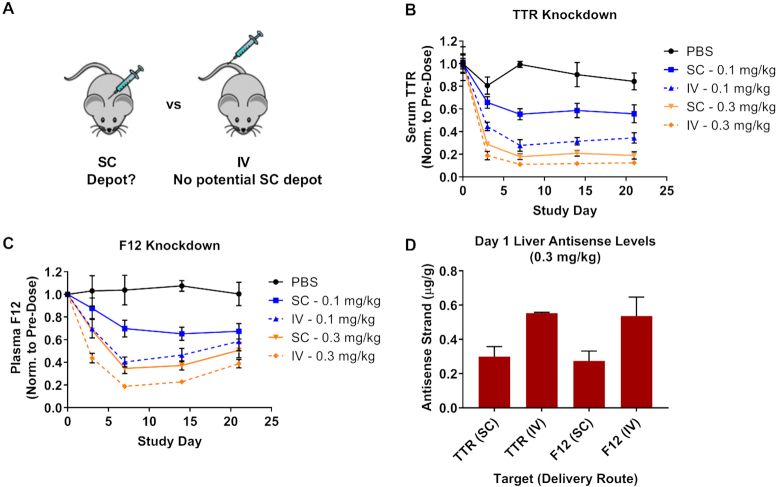
The SC site of injection is not a depot for GalNAc–siRNA conjugates. (A) Schematic illustrating the location of SC (back) and IV (tail) injection sites for the GalNAc–siRNA conjugates used in this comparison (note: IV-injected GalNAc–siRNA was not LNP-formulated). (B, C) Cohorts of mice (n = 3) were dosed by SC or IV injection at 0.3 or 0.1 mg/kg with Advanced ESC GalNAc–siRNA conjugates targeting Ttr (B, siTTR-2) or F12 (C, siF12-1) mRNA. (D) Antisense siRNA levels (μg/g, μg antisense strand per gram of liver) were measured from total liver collected one day post-dose from the 0.3 mg/kg groups. The route of administration (RoA) is indicated. Data is represented as mean ± SD, for N = 3.